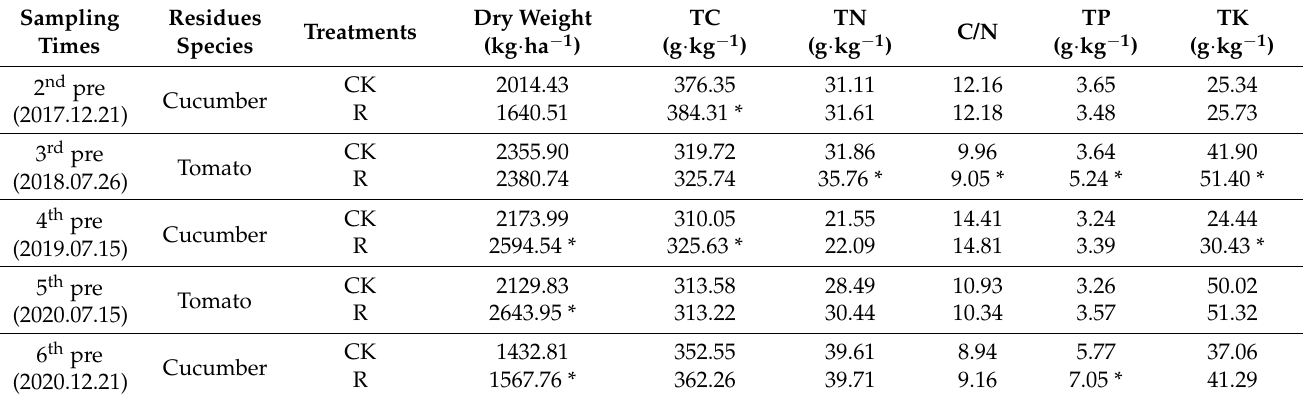
Table 4. The dry weight and physicochemical characteristics of vegetable residues.